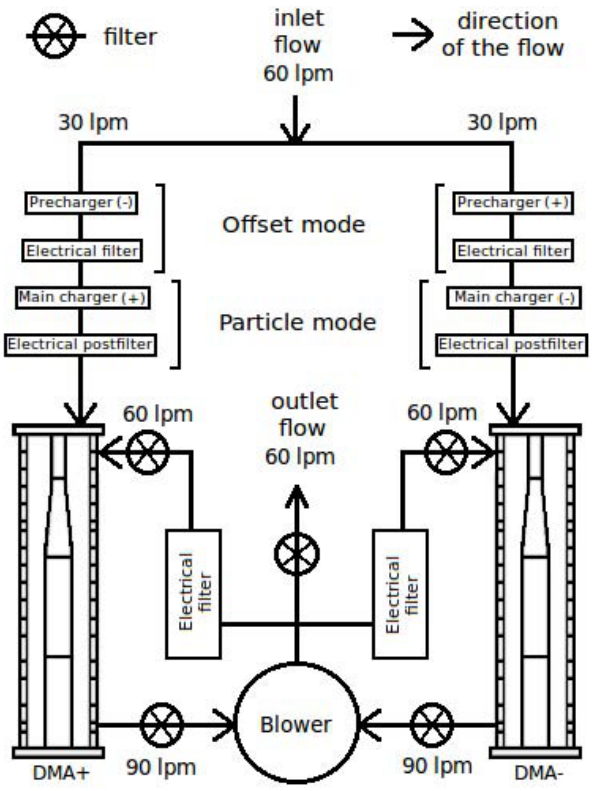
Fig. 1. Schematic figure of an NAIS. The inlet flow is 60lpm split into two, 30lpm for each polarity. The offset mode box is active only during the offset measurement mode; and the particle mode box is active only during the particle measurement mode. In the AIS, the particle mode box does not exist. The ANAIS has a dif- ferent design with multiple blowers to control different parts of the